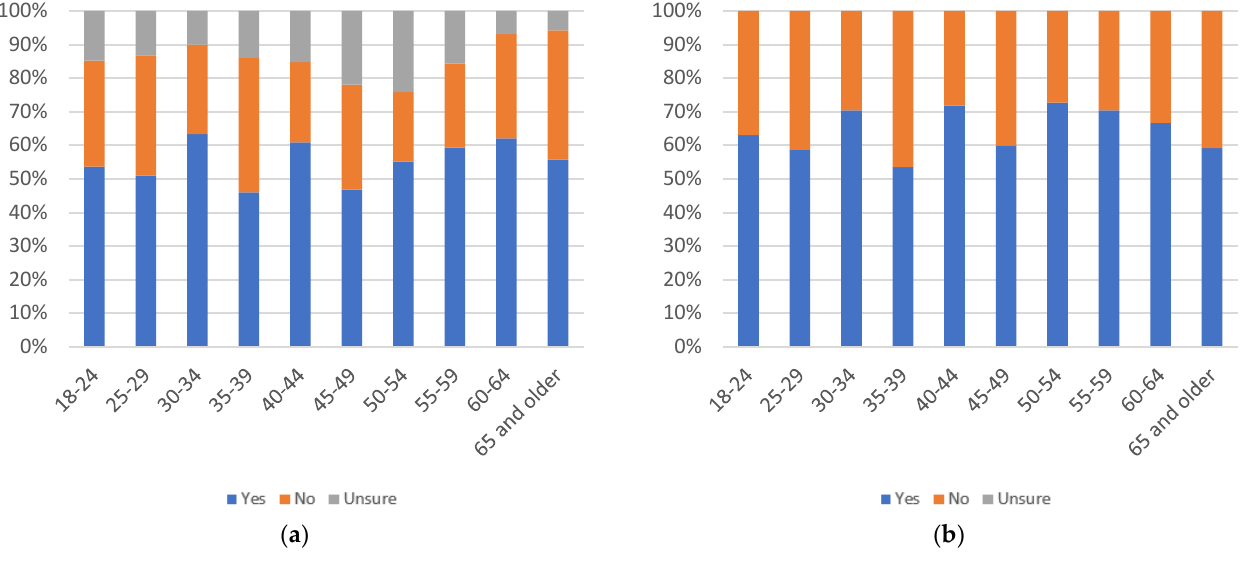
Figure 91. Label use, by age group: ( a ) with uncertain respondents (left) and ( b ) without uncertain respondents (right).